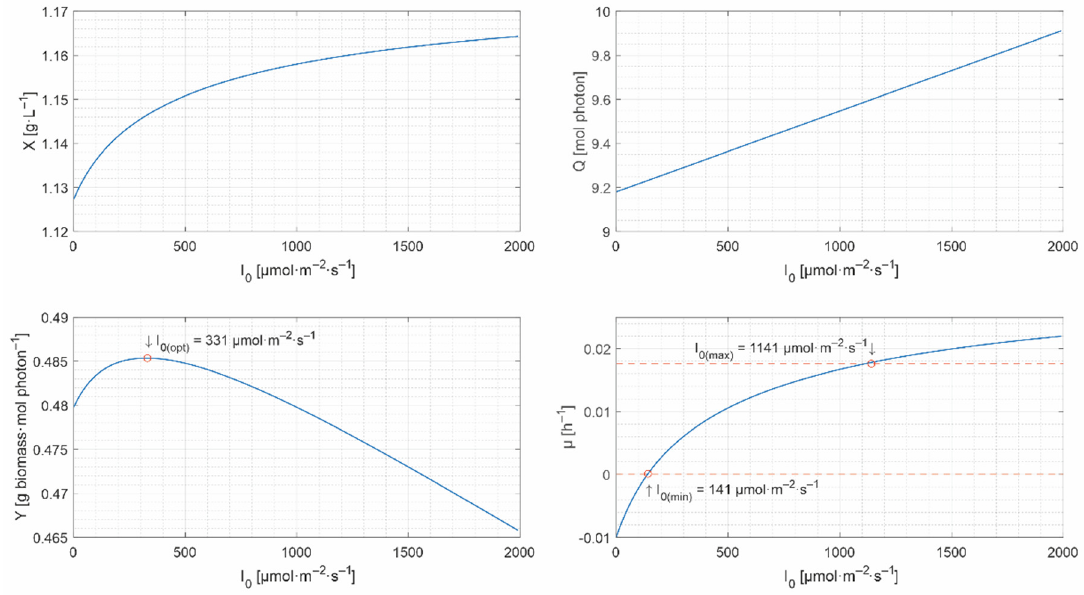
Figure 4. The response of the system for 𝐼 (cid:2868) ∈ (cid:4670) 1,2000 (cid:4671) μ mol ∙ m − 2 ∙ s − 1 on a one ‐ hour horizon.